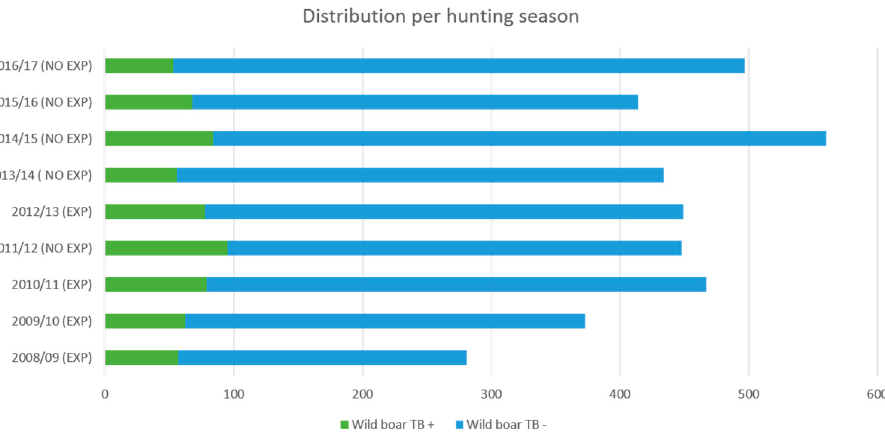
Figure 2. Distribution per hunting season (exposed/non-exposed) of wild boar that were TBL positive (green) and TBL negative (blue).